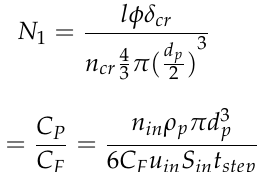
Table 3. Physical properties of the deposition model.